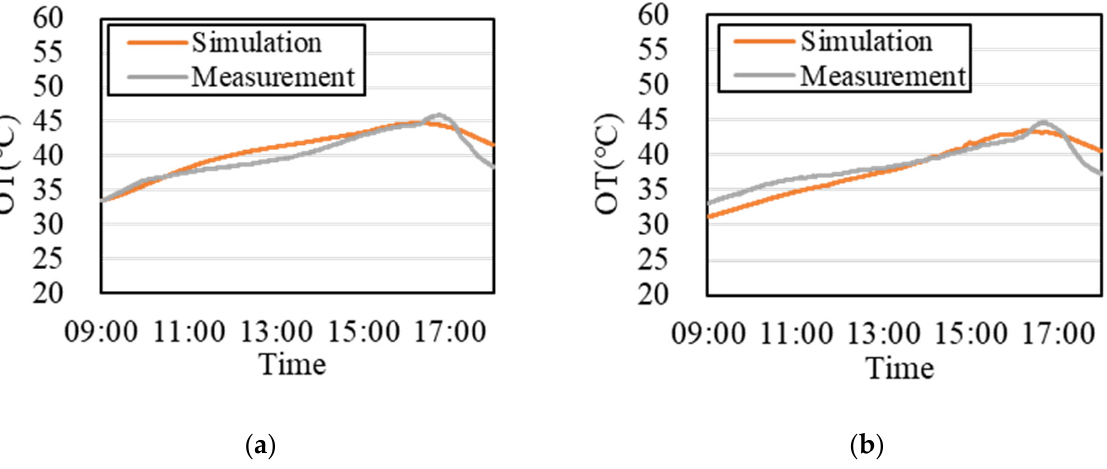
Figure 11. MRT comparison of simulation and measurement. ( a ) Without Expanded Metal Mesh; ( b ) With Expanded Metal Mesh.